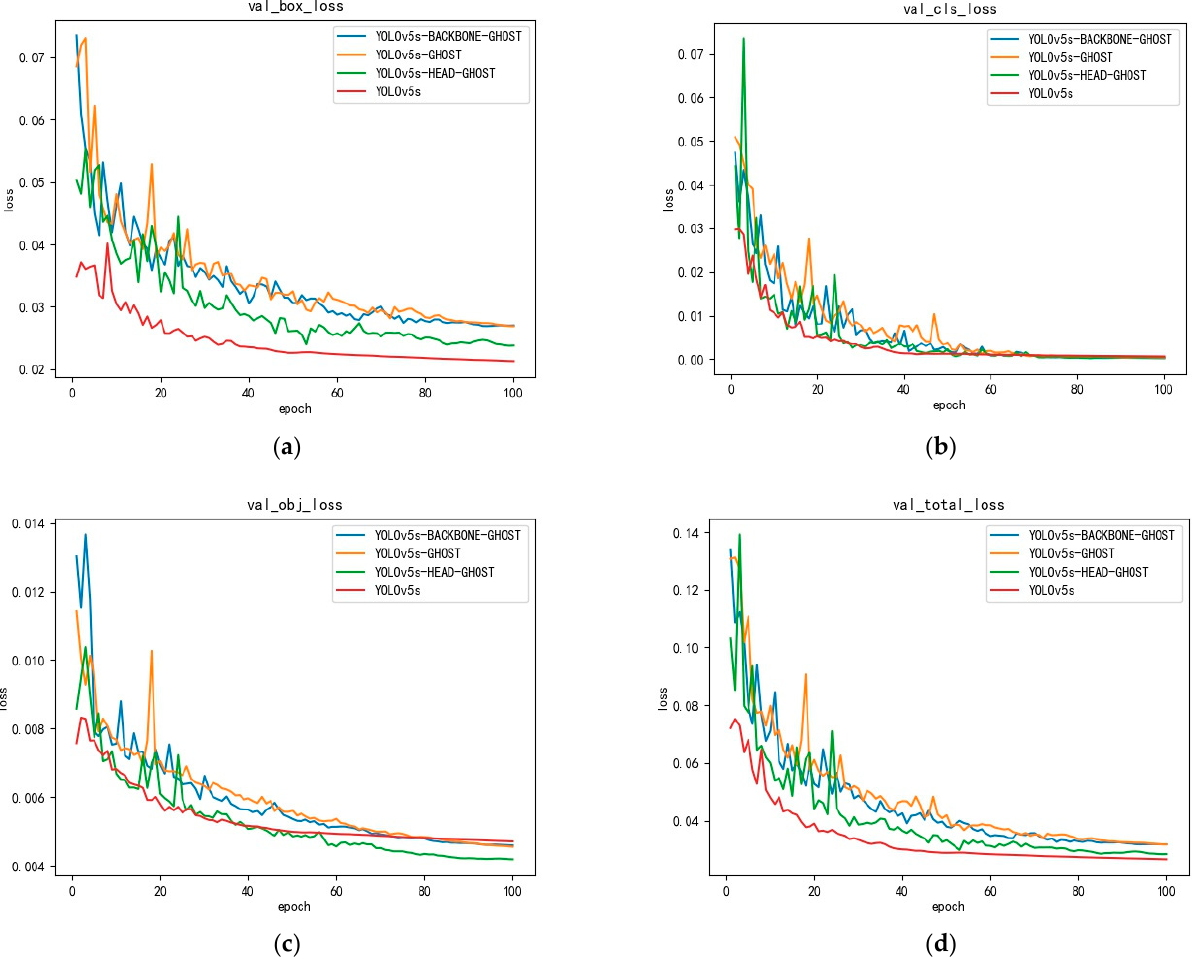
Figure 10. Val loss curve: ( a ) is the box loss, ( b ) classify loss, ( c ) object loss, ( d ) total loss. Table 6. mAP and detection time of each model.